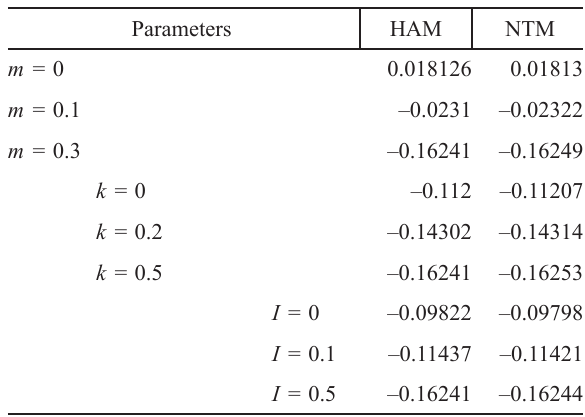
Table 4 – Effect of parameters on dimensionless wall couple stress, (Re) 1/2 M w Parameters